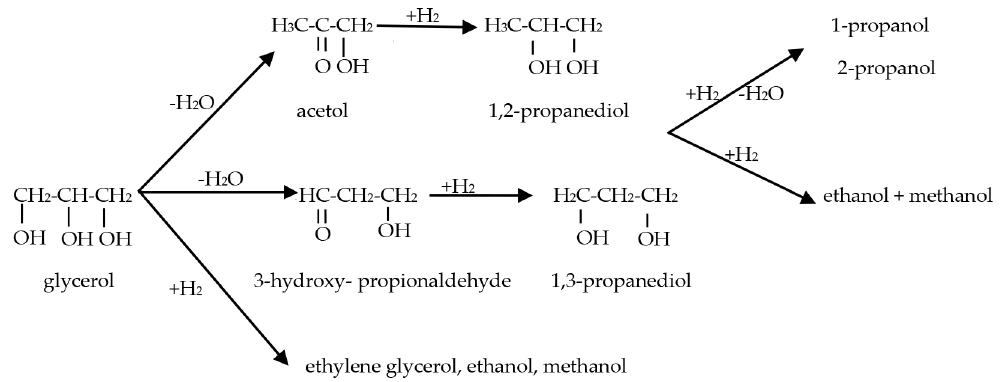
Figure 1. Reaction scheme of glycerol